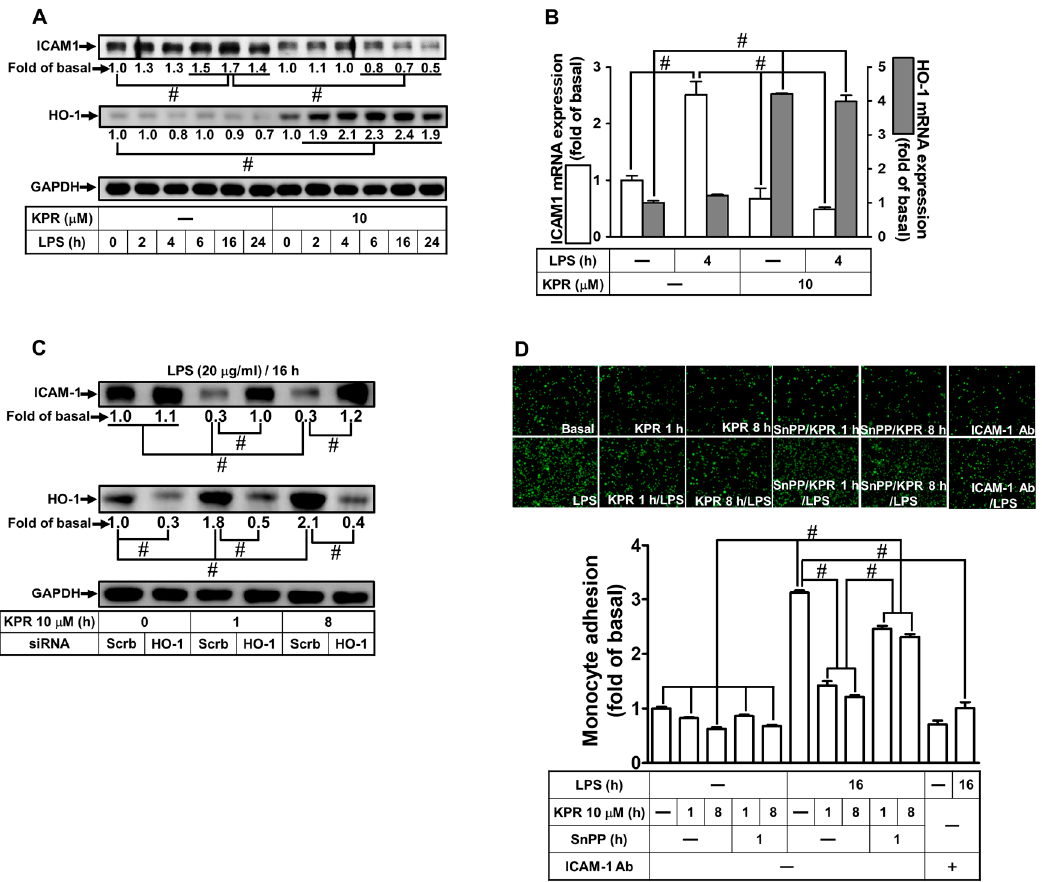
Figure 1. KPR inhibits ICAM-1 expression induced by LPS via HO-1 upregulation in HPAEpiCs. ( A ) HPAEpiCs were pretreated with KPR (10 μ M) for 1 h, and then incubated with LPS (20 μ g/mL) for the indicated time intervals. The protein levels of ICAM-1 and HO-1 were determined by Western blot using GAPDH as a loading control. ( B ) Cells were pretreated with KPR (10 μ M) for 1 h, and then incubated with LPS (20 μ g/mL) for 4 h. The levels of ICAM-1 and HO-1 mRNA were determined by real-time PCR. ( C ) Cells were transfected with scrambled or HO-1 siRNA, treated with KPR (10 μ M) for 1 or 8 h, and then incubated with LPS (20 μ g/mL) for 16 h. The levels of ICAM-1 and HO-1 protein were determined by Western blot using GAPDH as a loading control. ( D ) Cells were pretreated KPR for 1 h, then incubated by ZnPPIX for 1 h, and finally stimulated with LPS for 16 h. In addition, cells were incubated with LPS for 16 h and treated with an anti-ICAM-1 neutralizing antibody (2 μ g/mL) for 1 h. The adhesion of THP-1 cells (displayed in green) was measured. Data are expressed as mean ± SEM ( n = 5), analyzed with one way ANOVA and Dunnett’s post hoc test. # p < 0.01, as compared with the cells exposed to vehicle alone; or significantly different as indicated.